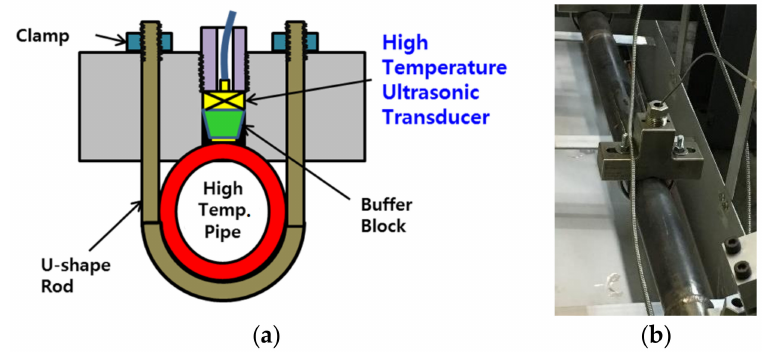
Figure 1. ( a ) An assembly drawing diagram of a high temperature pipe using a bu ff er-rod type measurement system; ( b ) an installed bu ff er-rod type system for thickness monitoring on a